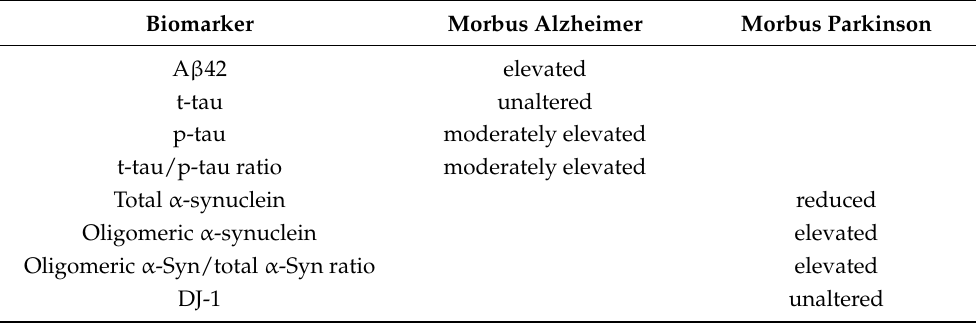
Table 7. Potential salivary biomarkers associated with AD and PD described in studies. Biomarker Morbus Alzheimer Morbus Parkinson A β 42 elevated t-tau unaltered p-tau moderately elevated t-tau/p-tau ratio moderately elevated Total α -synuclein reduced Oligomeric α -synuclein elevated Oligomeric α -Syn/total α -Syn ratio elevated DJ-1